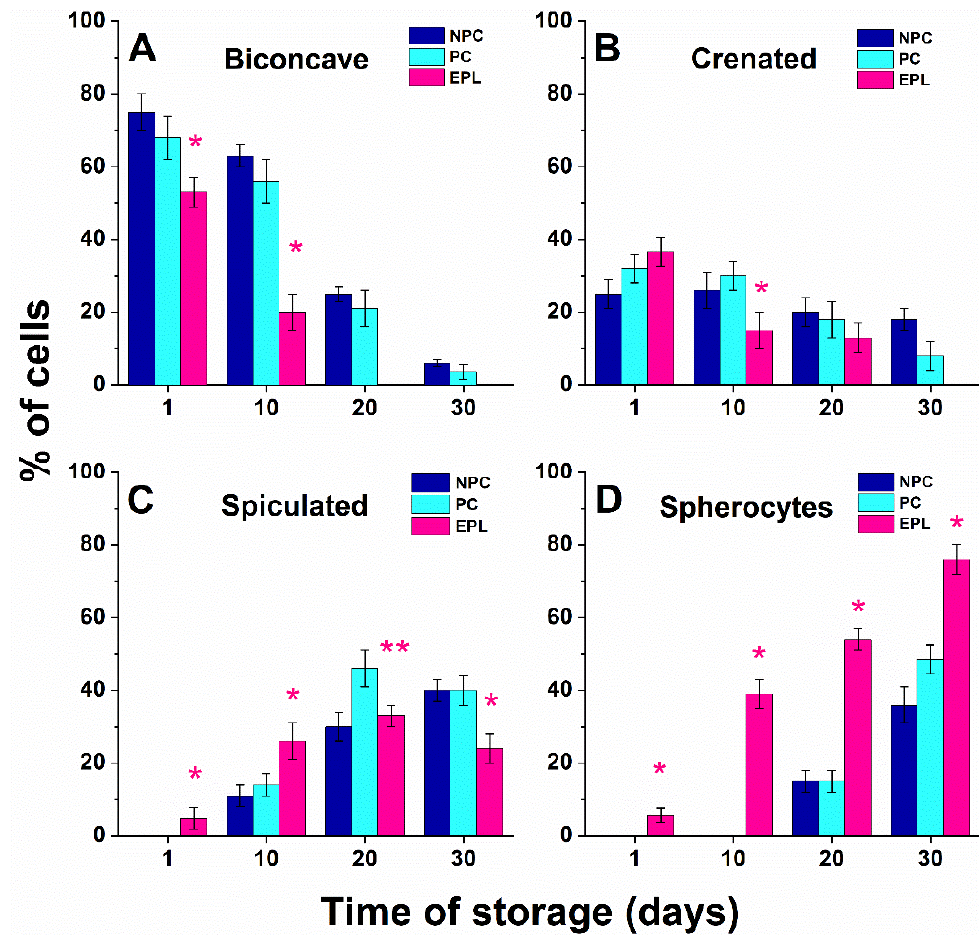
Figure 2. Histogram of the relative fraction of erythrocytes assigned to the four morphological types ( A – D ) during aging of the cells isolated from the blood of healthy nonpregnant controls (NPC, dark blue bars), healthy pregnant controls (PC, light blue bars), and women with early pregnancy loss (EPL, red bars). Each morphological type is represented as a percentage of the total number of cells. Non-parametric Wilcoxon test was used to determine statistical differences in the fraction of different morphological types of EPL cells, which are given as p values, indicated as * p < 0.05 relative to both NPC and PC, ** p < 0.05 relative to PC.